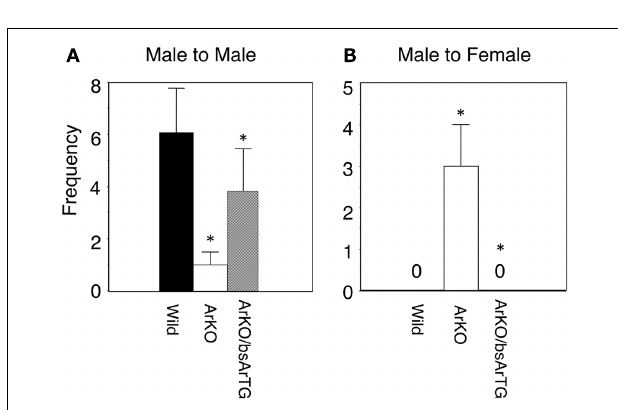
FIGURE 4 | Infanticide behaviors in wild-type ( n = 9),ArKO ( n = 11), and ArKO/bsArTG ( n = 9) mice aged 13–15weeks. The incidence of the infanticide behavior is shown as a percentage, and statistically analyzed by the χ 2 -method. Significant differences of wild-type vs. ArKO and ArKO vs. ArKO/bsArTG are shown (* p <